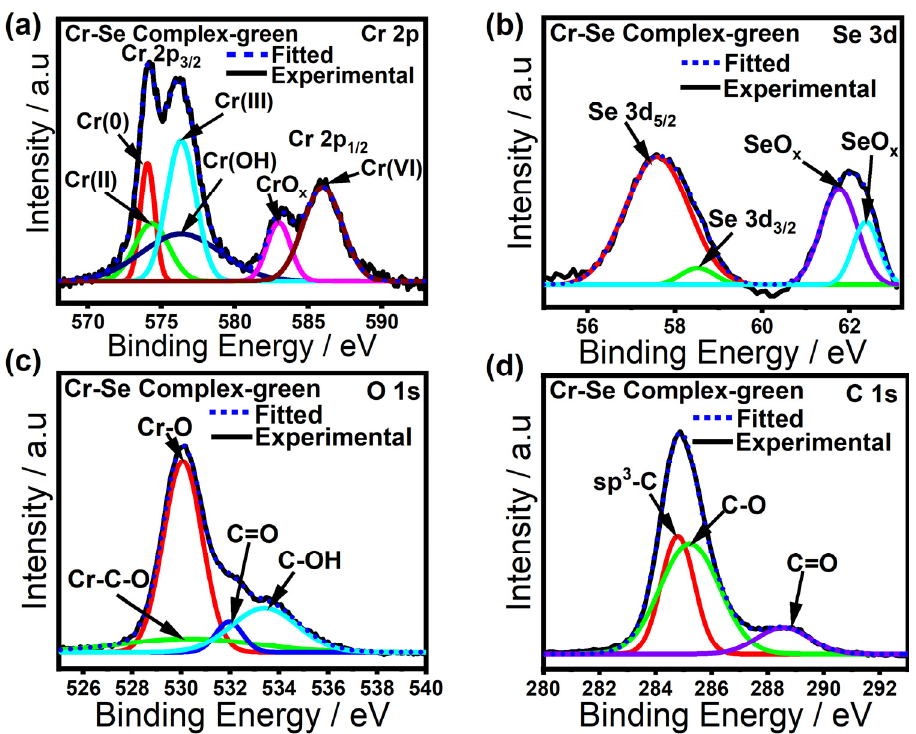
Figure 3. The high-resolution XPS spectra of Cr-Se green complex showing ( a ) Cr 2p peak; ( b ) Se 3d peak; ( c ) C s1 peak; ( d ) surface O 1s peak.